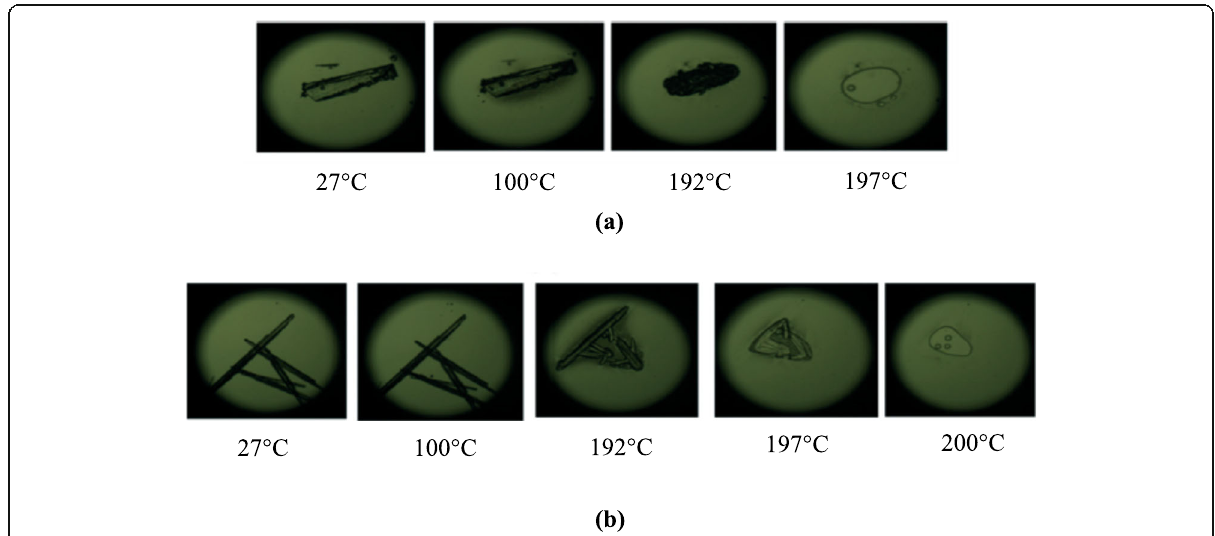
Fig. 4 HSM micrographs of urea:4,4 ′ -bipyridine cocrystal polymorphs at different temperatures. a Polymorph IA melts at 197 °C, b Polymorph IIB melts at 200 °C. Reprinted from Tothadi 2014 with permission from the